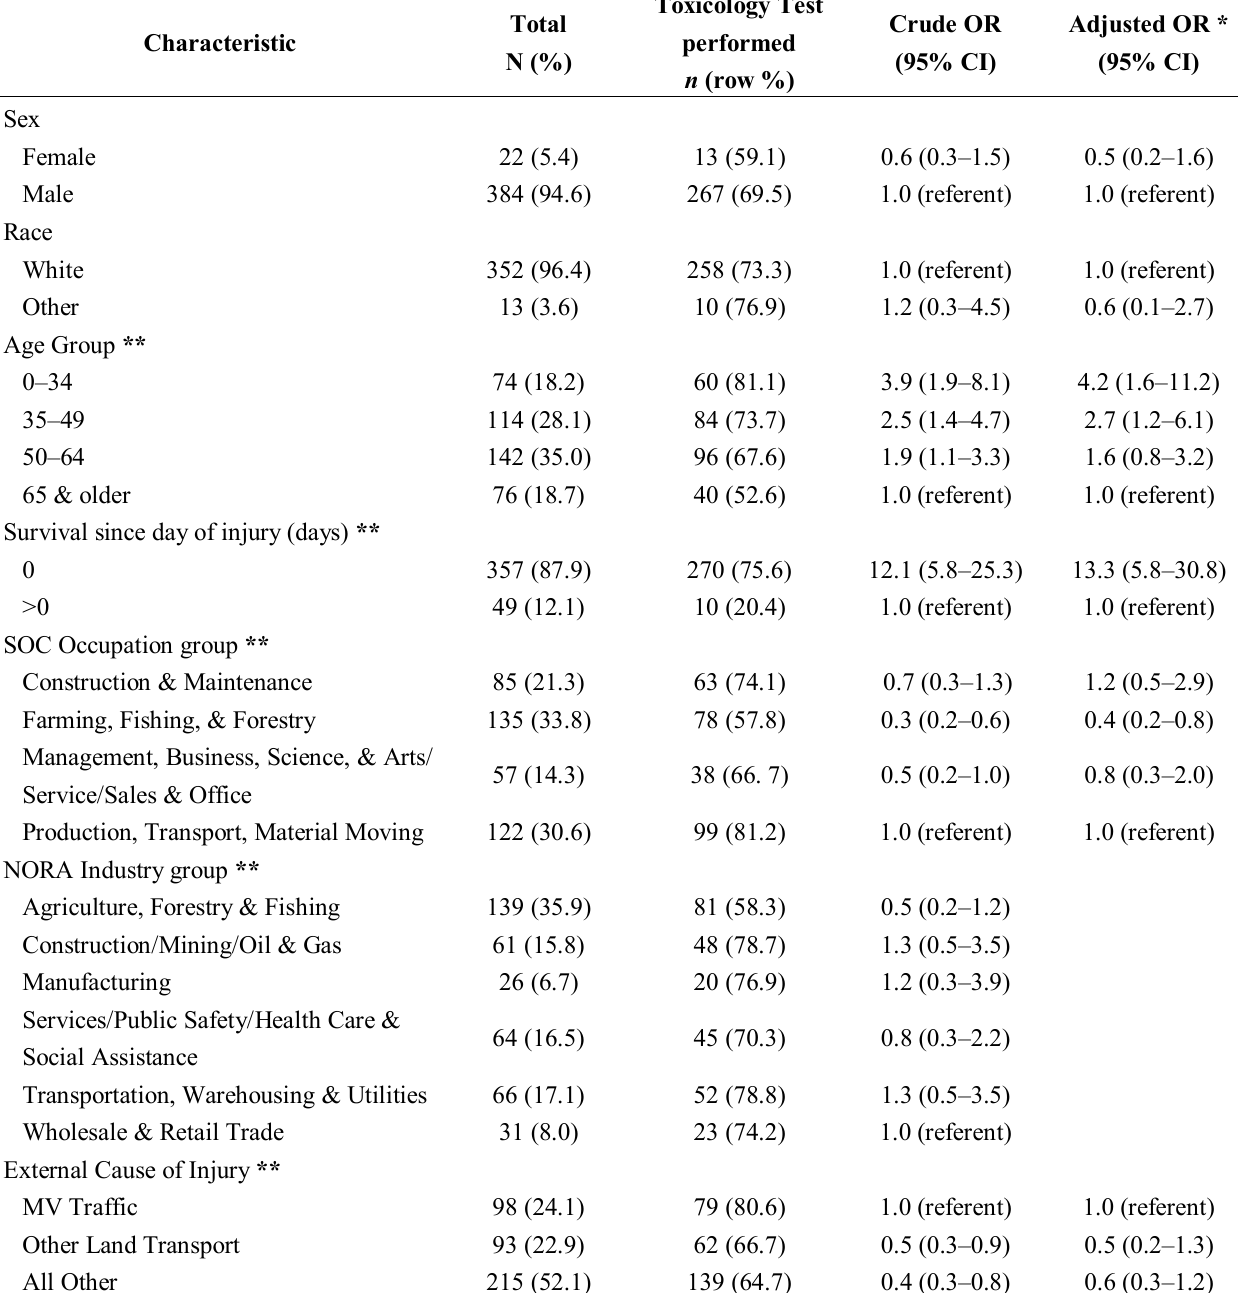
Table 2. Demographic, occupation, industry, and external cause by toxicology testing status ( n =